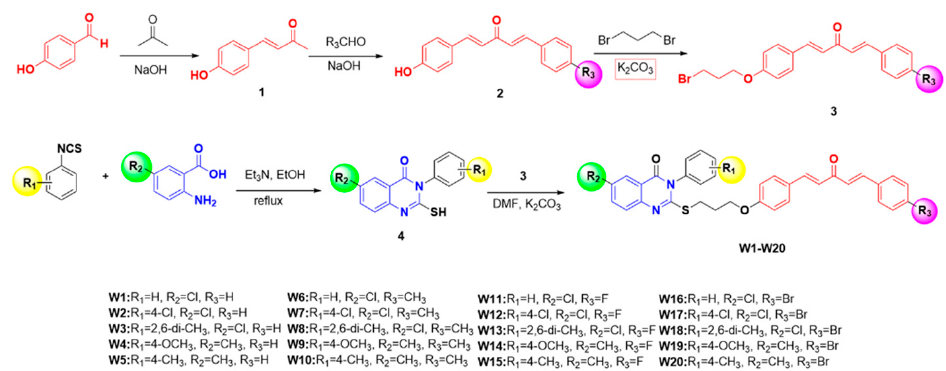
Scheme 1. Schematic representation of the synthesis of target compounds W1 – W20